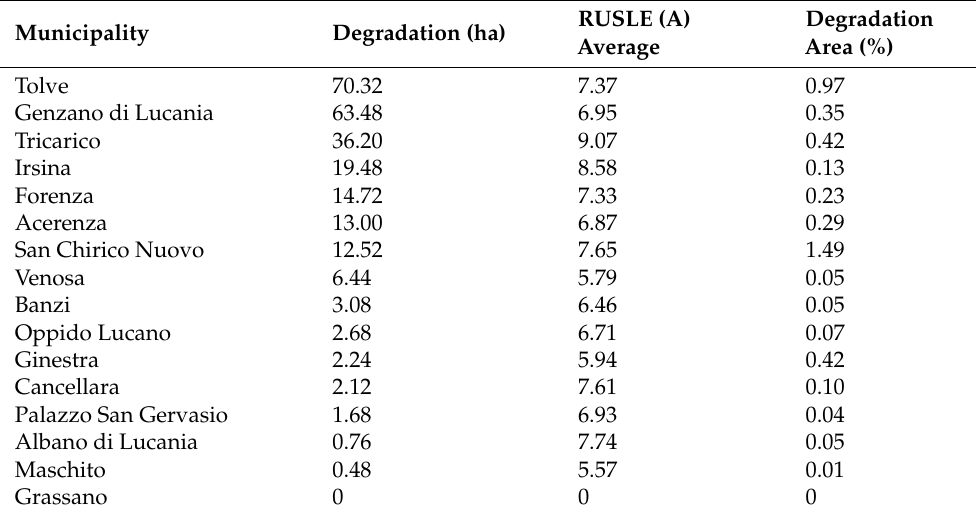
Figure 7. Map of degradation areas. Table 4. Extension of the areas subject to degradation cultivated with arable land in degradation concerning the factor C